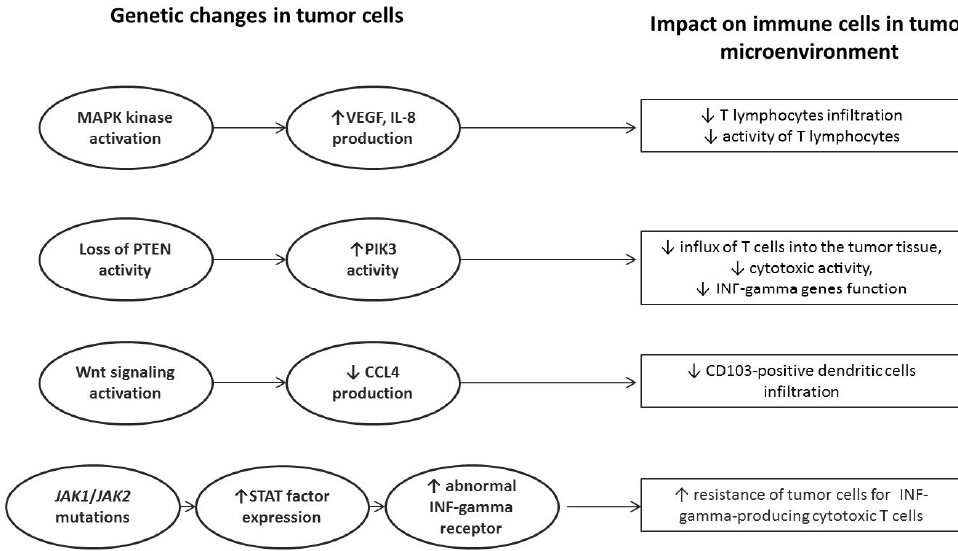
Figure 1. Impact of genetic abnormalities detected in tumor cells on the function of anticancer im- mune response.